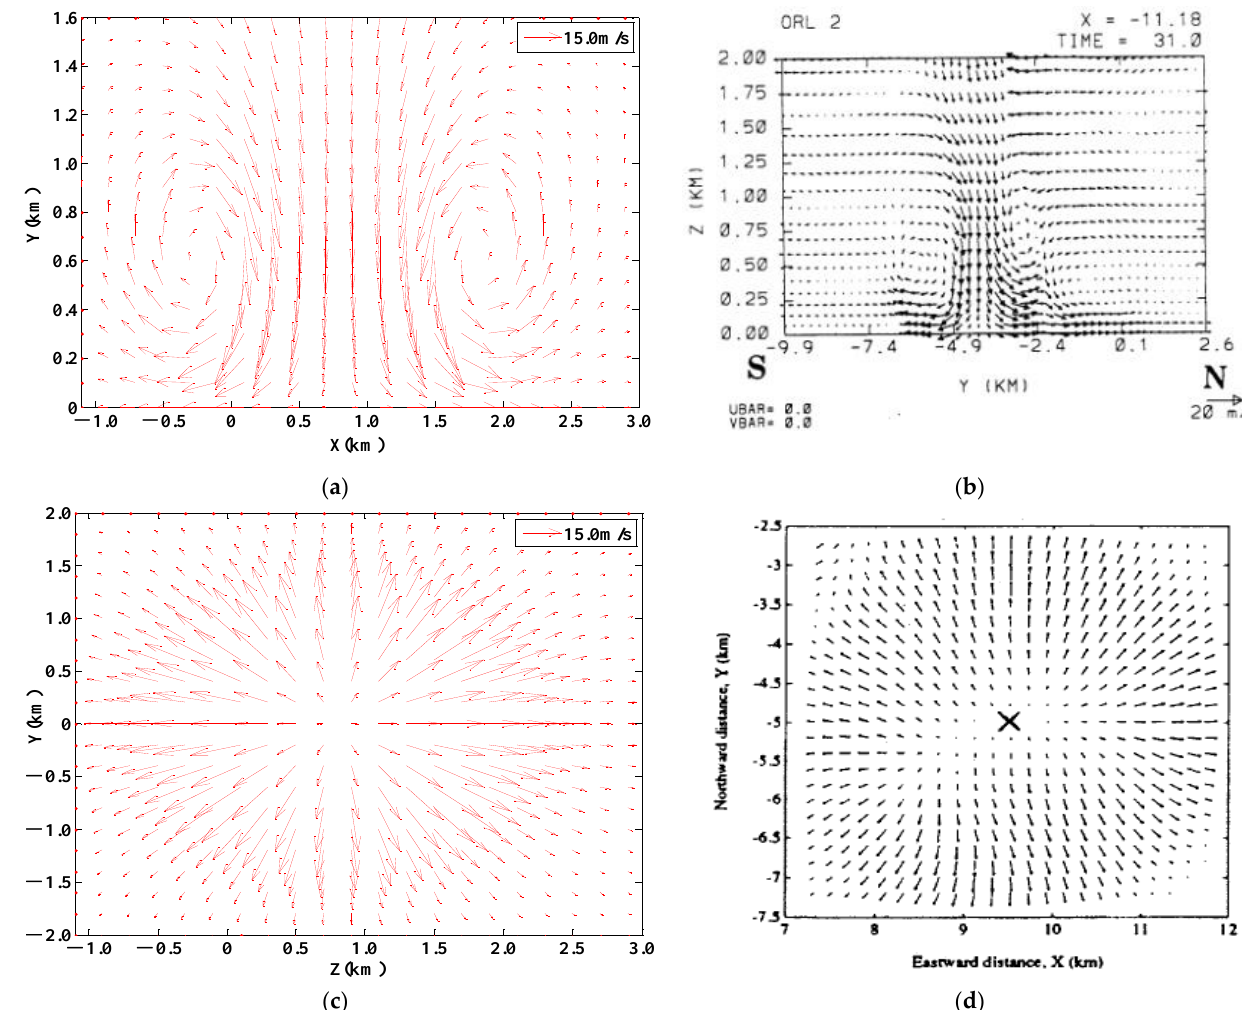
Figure 3. Comparisons between simulation results and measured data of micro-downburst. ( a ) Simulation wind vector diagram of horizontal section. ( b ) Flow pattern of 7 July 1990 Orlando downburst from NTRS-NASA Technical Reports Server [21]. ( c ) Simulation wind vector diagram of vertical section. ( d ) Flow pattern of 1988 microburst event of DEN from NTRS-NASA Technical Reports Server